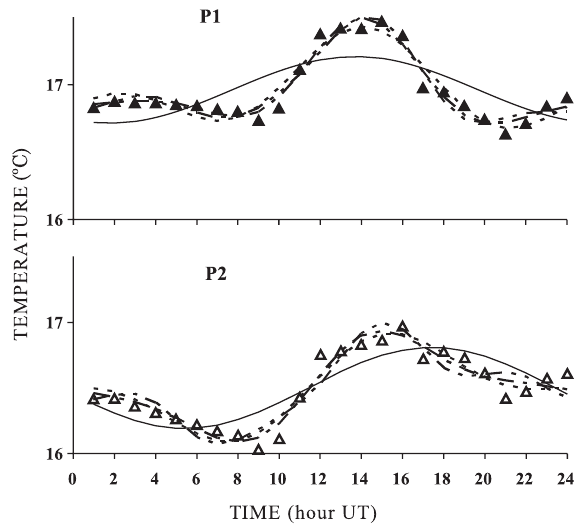
Figure 4. Time-course of temperature at 16 cm depth, in soil profiles P1 ( ) and P2 ( ) measured and simulated with the first ( ___ ), the first two ( --- ), the first three (— - —) and the first four Fourier harmonics (— — —) in a pine- forested Haplic Podzol on day M (moist soil) (P1 is the profile with litter layer and P2